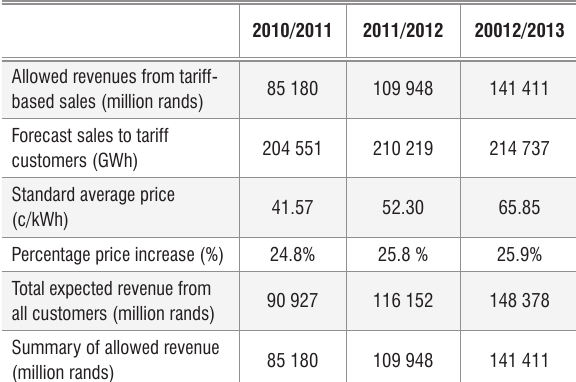
Sectorial breakdown of the second multi-year pricing deter-